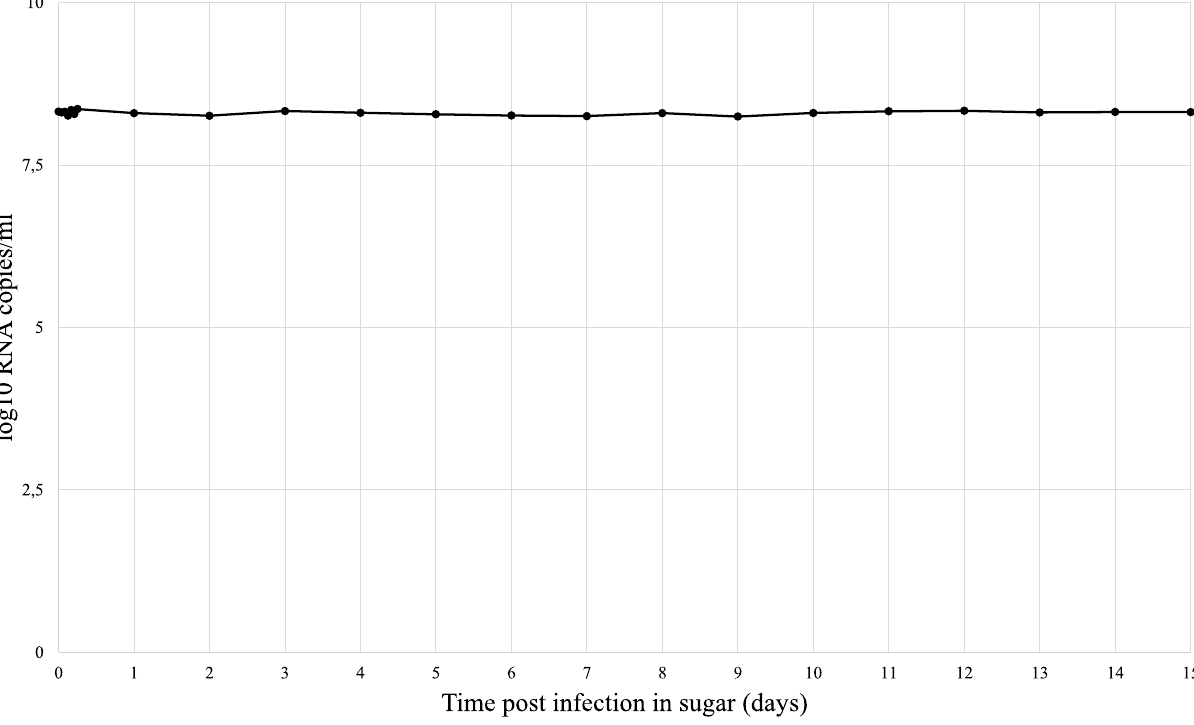
Figure 2. Toscana virus RNA load (log 10 copies/ml) in sugar solution over time post infection.